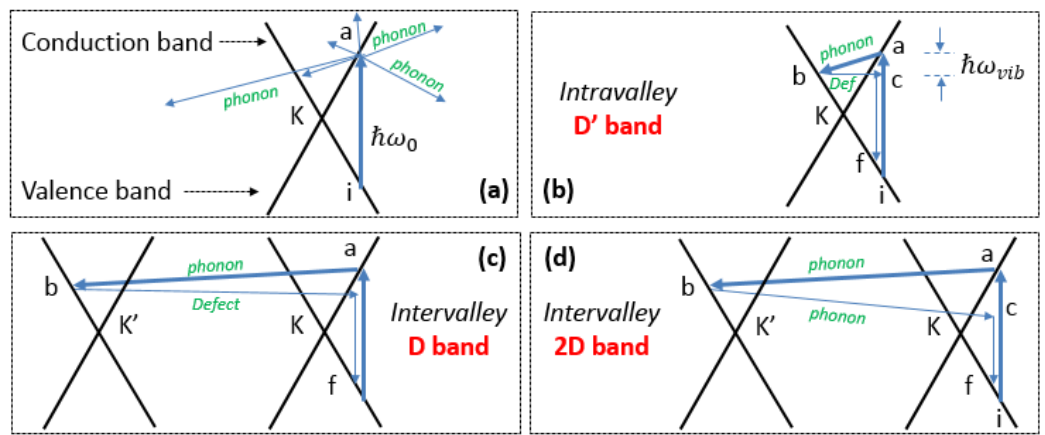
Figure 9. Double resonant scattering for the valence and conduction bands, adapted from [92]. ( a ) Electron ‐ hole excitation followed by non ‐ resonant phonon scattering. ( b ) Intravalley process giving rise to the D’ band: Phonon (resonant) + defect scattering. ( c , d ) Intervalley processes giving rise to D and 2D processes with phonon (resonant) + defect and double phonon processes, respectively.